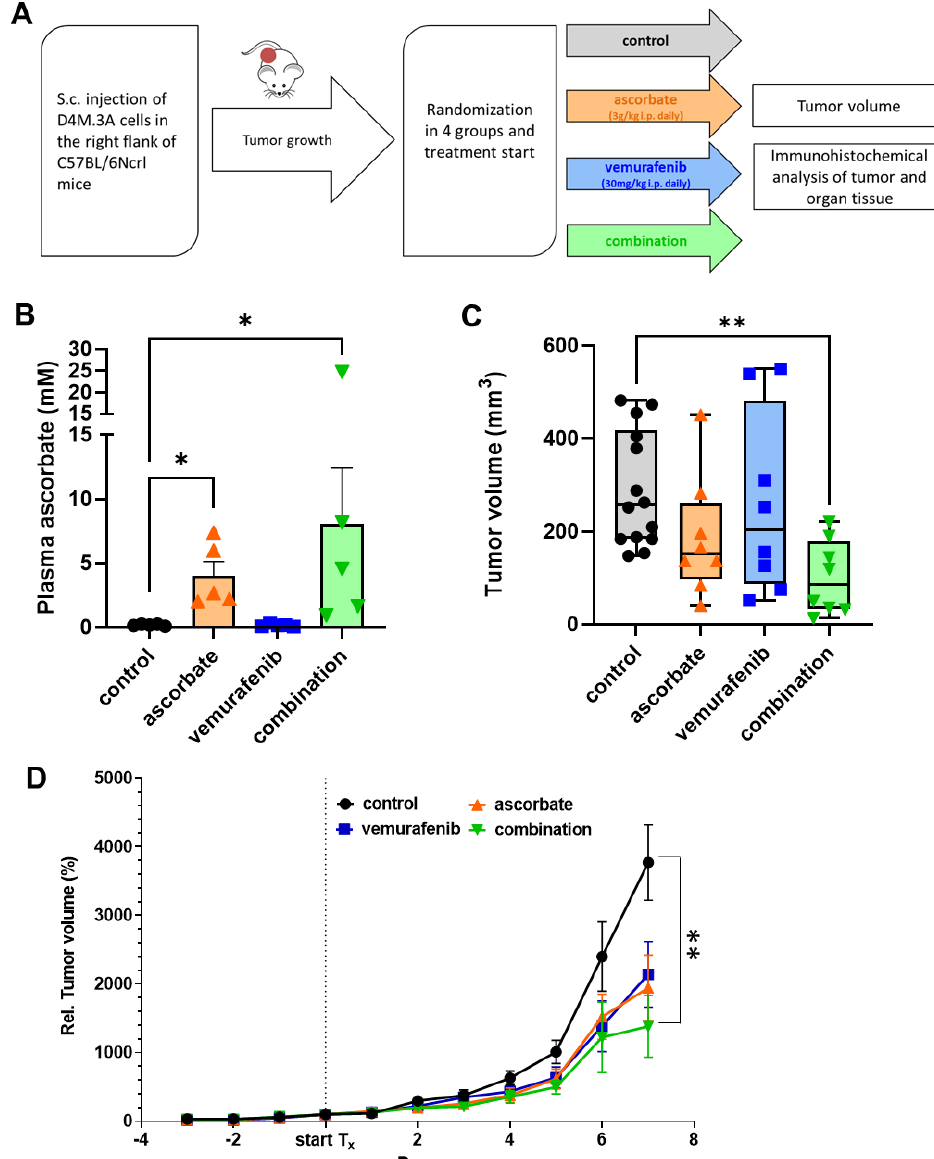
Figure 5. Effects of ascorbate and vemurafenib in an in vivo C57BL/6NCrl mouse model with subcutaneously injected isogenic D4M.3A melanoma cells. ( A ) Treatment scheme of in vivo mouse experiment. ( B ) Measurement of blood plasma levels of ascorbate in solvent injected control mice and mice receiving ascorbate (3 g/kg i.p., daily), vemurafenib (30 mg/kg i.p., five times weekly), and their combination; ( C ) Endpoint tumor volume measurement after 7 days of treatment with ascorbate (3 g/kg i.p. daily), vemurafenib (30 mg/kg i.p., five times weekly), and their combination; ( D ) Measurement of the tumor volume during treatment with ascorbate (3 g/kg i.p., daily), vemurafenib (30 mg/kg i.p., five times weekly), and their combination. The tumor volume was normalized to the tumor volume at the start of treatment to get the relative tumor volume. Shown are the mean values of normalized tumor volume +/ − SEM. *: p ≤ 0.05; **: p ≤